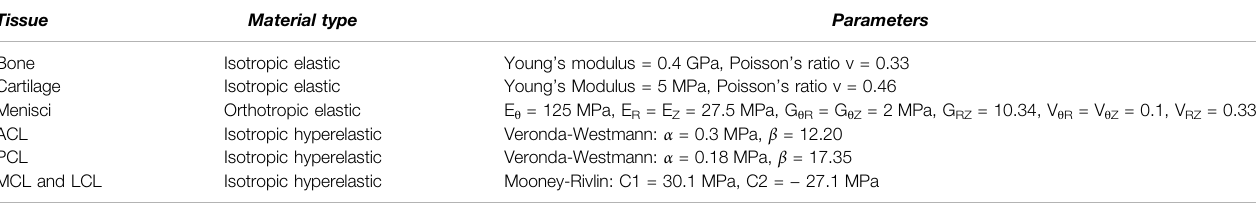
TABLE 1 | Material properties of the tissues in the knee model (Wang et al., 2020b). Tissue